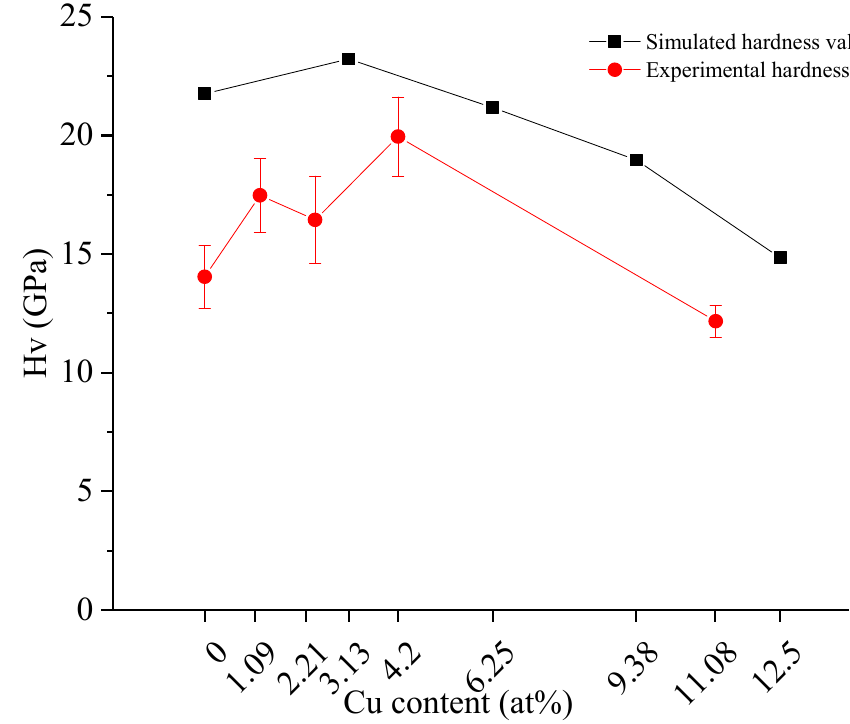
Figure 5. Hardness of TiCuN with different Cu contents.